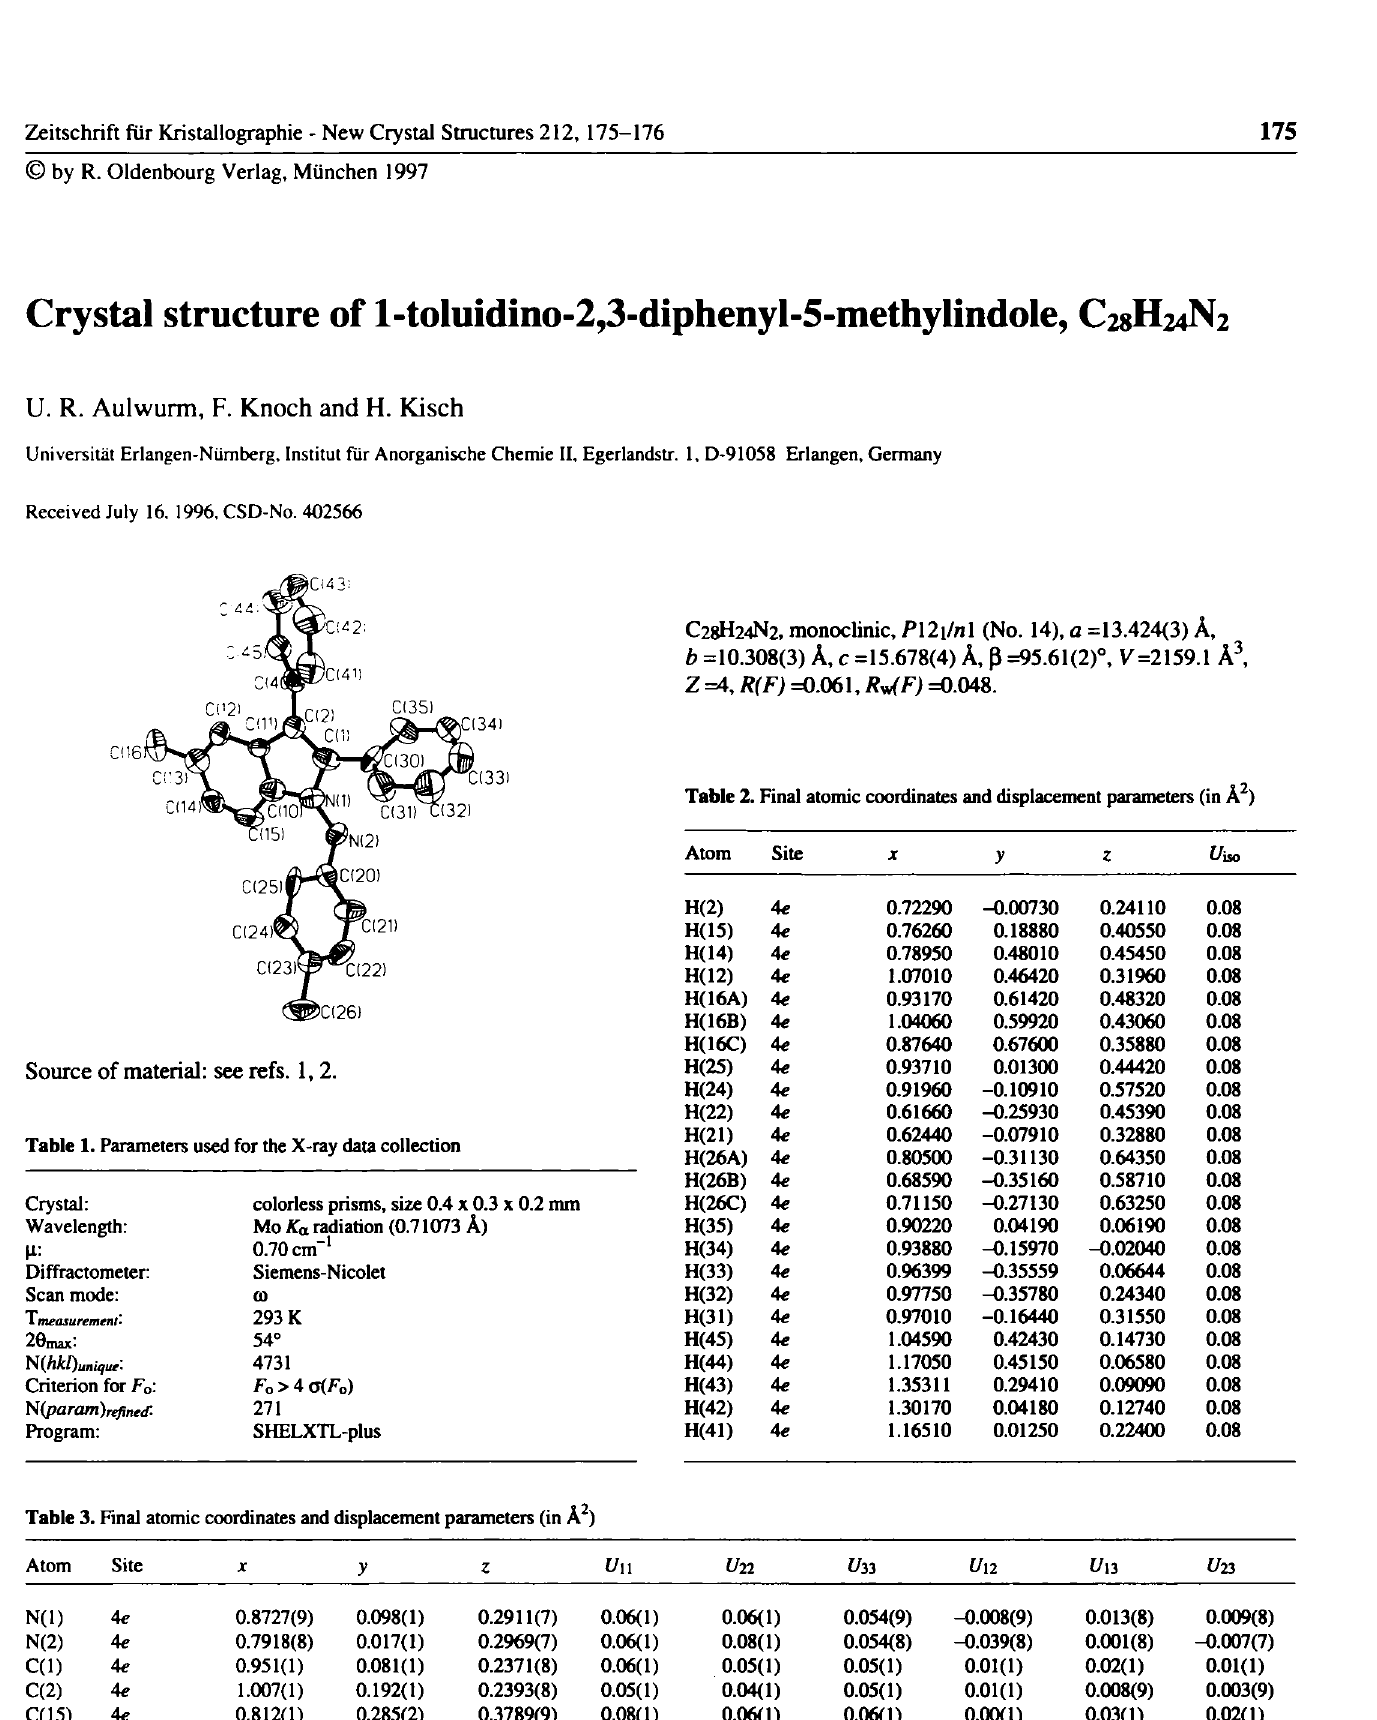
Table 3. Final atomic coordinates and displacement parameters (in Â 2 ) Atom